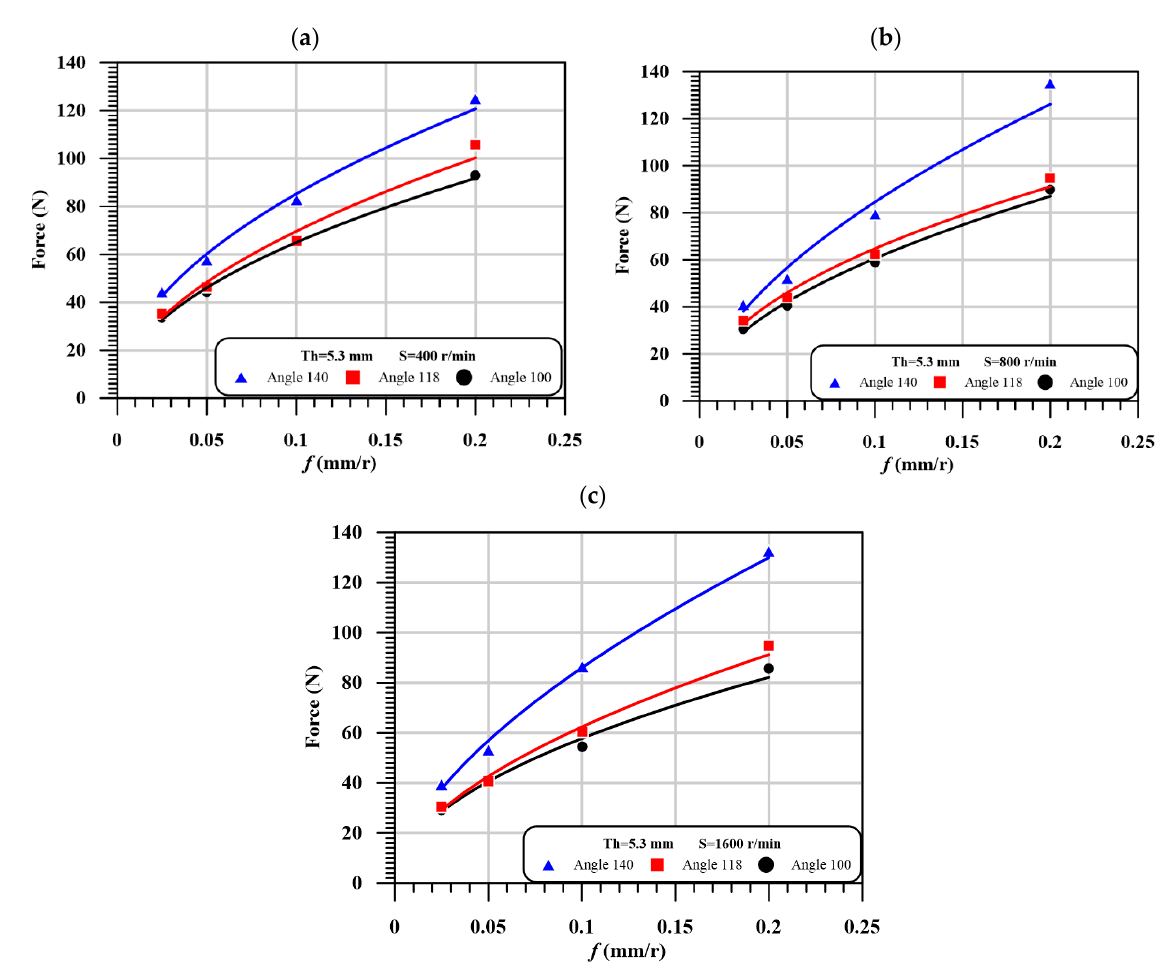
Figure 8. The influence of feed on the critical thrust force with different point angles at different speeds, ( a ) At thickness of 5.3 mm and speed = 400 r/min; ( b ) At thickness of 5.3 mm and speed = 800 r/min; ( c ) At thickness of 5.3 mm and speed = 1600